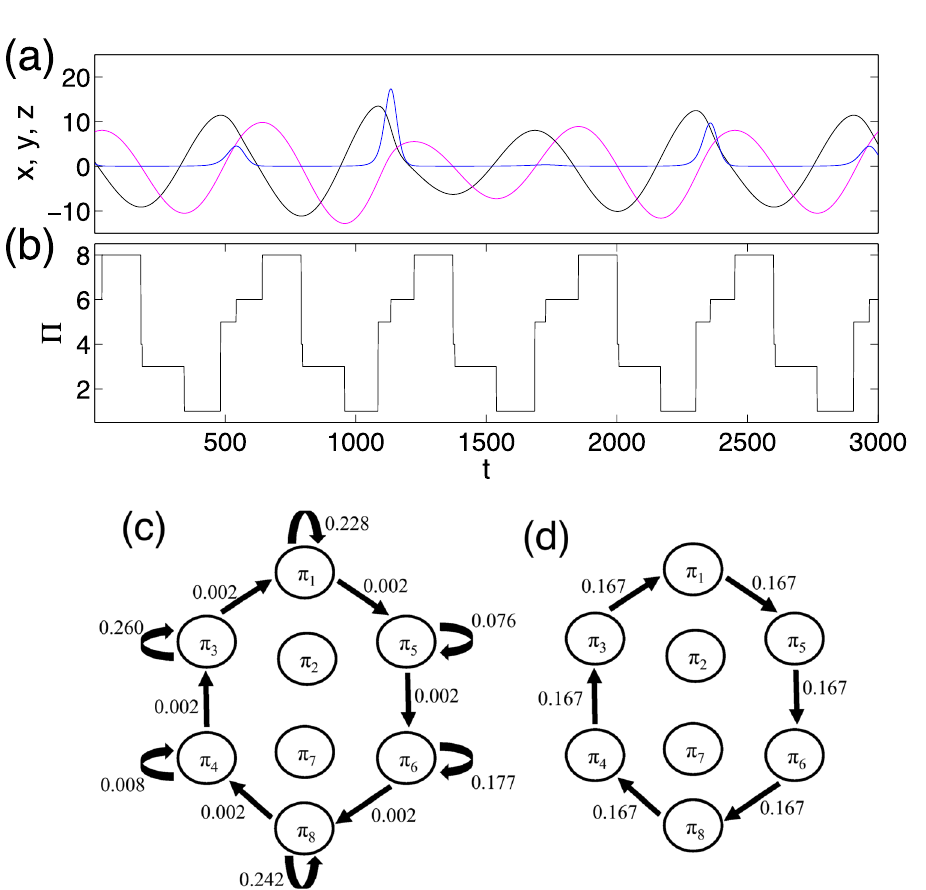
Figure 4. Chaotic Rössler system ( a = 0.165): ( a ) short segments of time series ( x , y , z ), ( b ) temporal variation of order patterns corresponding to the particular time window of ( a , c ) ordinal pattern transition network with  , and ( d ) without self-loops, = . 2 585 self-loops, = . 2 283 O